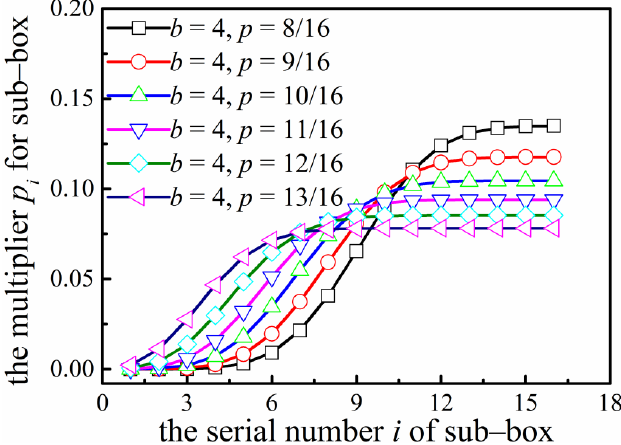
Figure 3. The multipliers calculated from the truncated binomial distribution of two parameters. For the two-parameter binomial multiplicative cascades of the deterministic algo- rithm, the generating function χ q ( δ = 1/ b n ) is expressed as